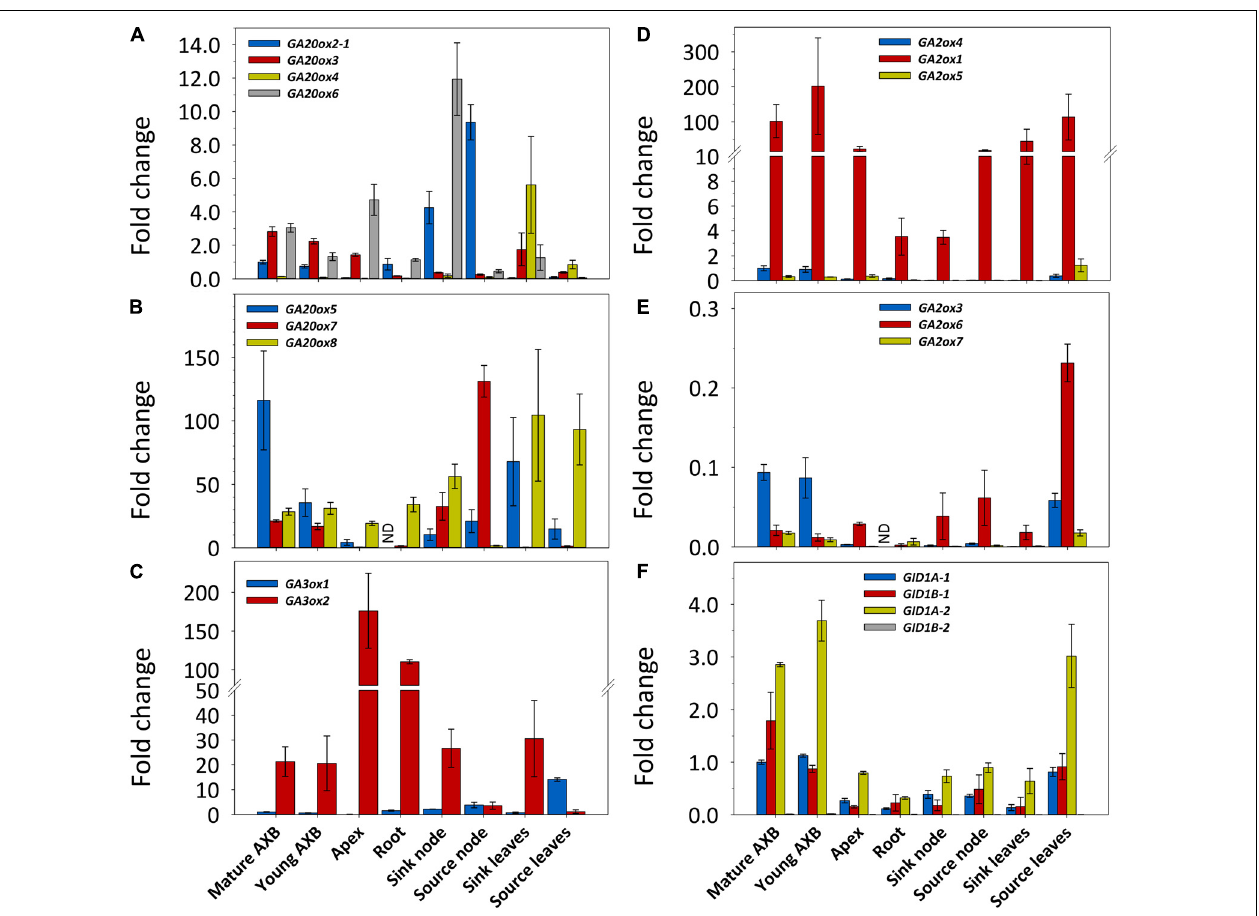
FIGURE 2 | Expression of gibberellin (GA) biosynthesis, deactivation and signaling genes in different plant parts in hybrid aspen. Relative expression (fold change) of GA20ox (A,B) , GA3ox (C) , GA2ox (D,E) , and GID1 (F) family genes. The two larger gene families are depicted in two separate graphs with high (B,D) and little (A,E) expressed genes. Values represent the means of three biological replicates ± S.E. ( n = six plants). ND, not detected. Fold changes are relative to reference gene expression in quiescent AXBs, set to 1. A moderately expressed gene within each family was selected for comparison: GA20ox2-1 , GA3ox1 , GA2ox4 , and GID1A-1